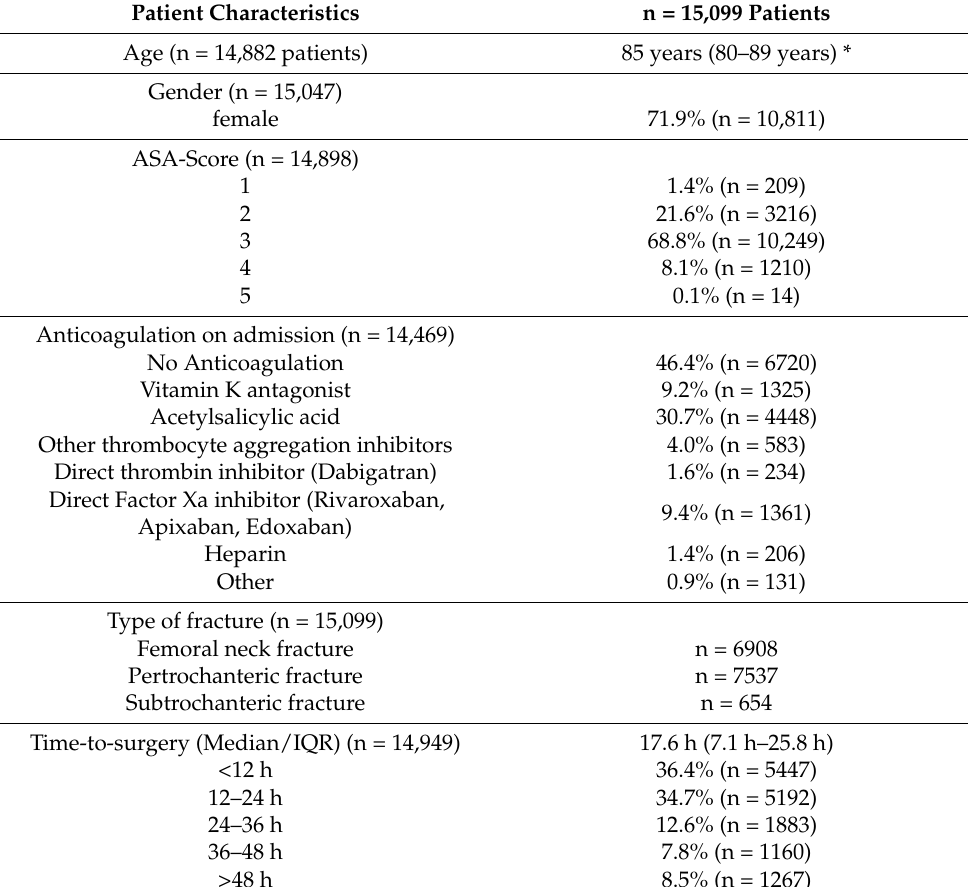
Table 1. Baseline characteristics of the study